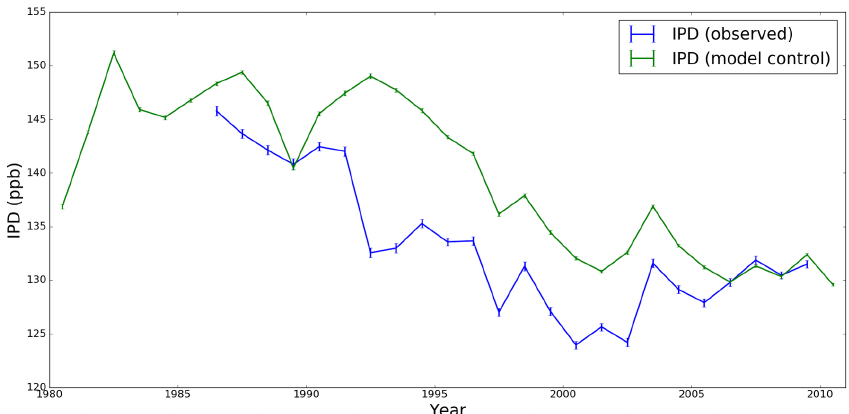
Figure 1. Annual mean IPD values (ppb) determined by NOAA ESRL and TM5 model atmospheric CH 4 mole fractions using data collected at seven geographical locations (Table 1). Vertical bars denote the 1 standard deviation associated with the annual